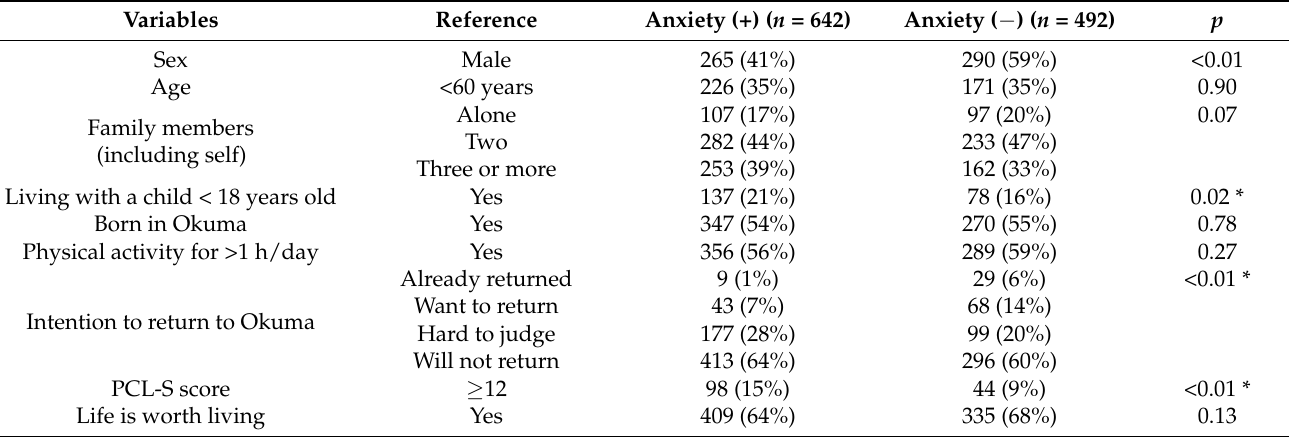
Table 1. Demographic factors and PCL-S scores of residents by risk perception for health effects of radiation exposure while living in Okuma.